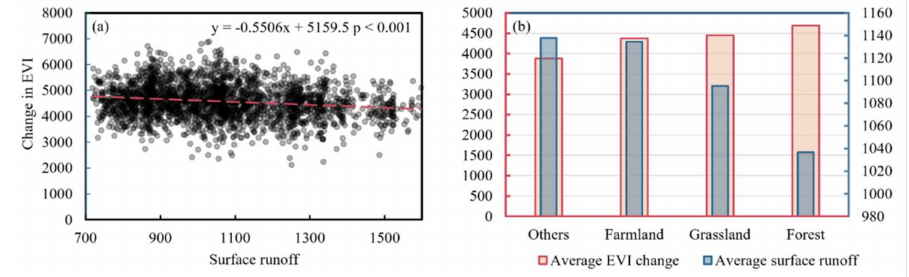
Figure 9. ( a ) Relationship between the change in EVI and annual surface runoff; ( b ) the EVI change and corresponding average surface runoff for different land cover